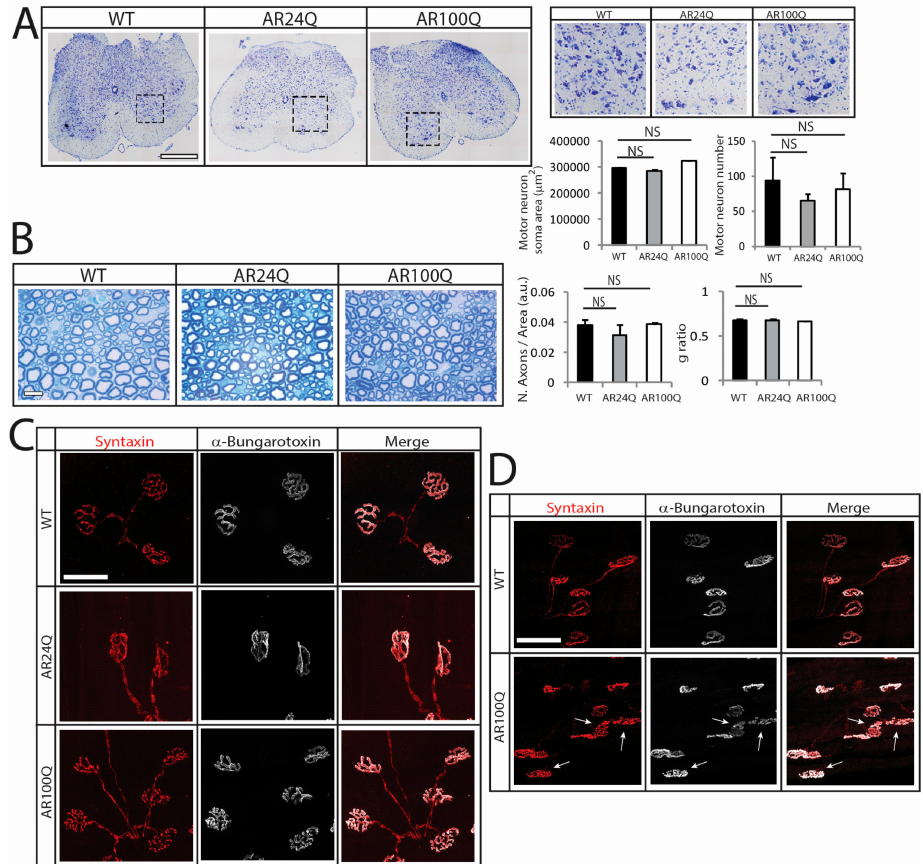
Figure 2. Late-onset alteration of NMJ morphology in AR100Q mice. ( A ) Nissl staining analysis of MN number and soma area in the lumbar spinal cord transversal sections of 12-week-old WT, AR24Q and AR100Q male mice ( n = 3). Inset position is shown by the dashed square box. Bar, 500 micron. ( B ) Toluidine blue staining of semi-thin sciatic nerve transversal sections of 8-week-old WT, AR24Q and AR100Q male mice ( n = 3). Bar, 10 micron. ( C – D ) Immunohistochemical analysis of NMJ pathology in the quadriceps muscle of 8-week-old ( C ) and 12-week-old ( D ) WT, AR24Q and AR100Q male mice ( n = 3). Arrows indicate fragmented NMJs. Bar, 50 microns. Shown are representative images. Graphs, mean ± SEM. Statistical testing: One-way ANOVA followed by Newman-Keuls post-hoc test; NS,